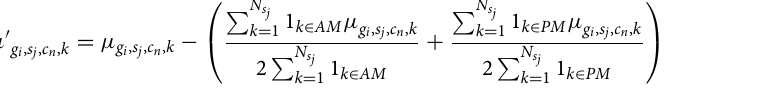
Figure art. All drawings (Figs. 1a,b, S2a) are generated using BioRender.com. Figure 1e was generated using GraphPad Prism